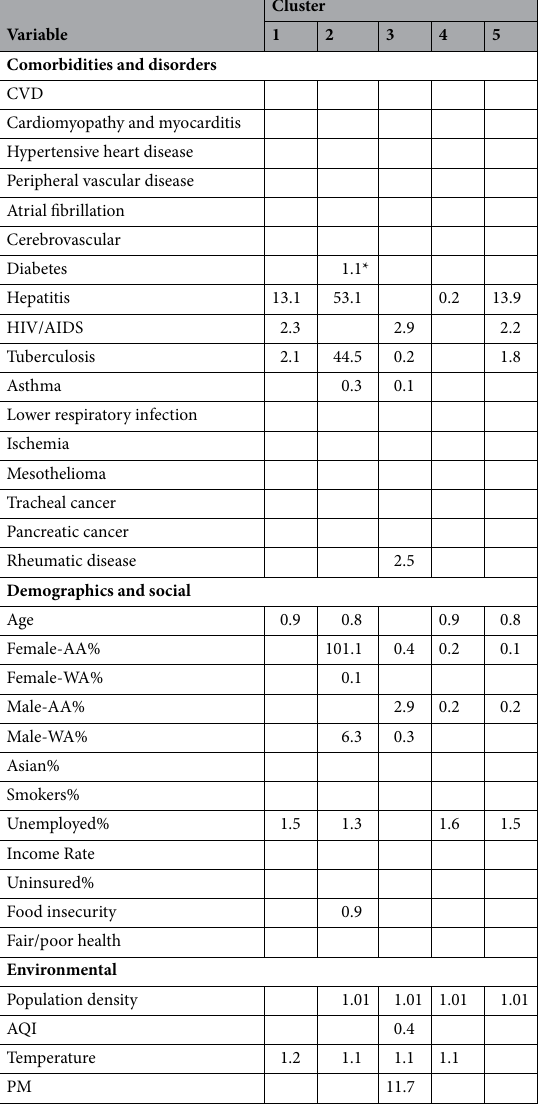
Table 6. 2nd Wave (Jun 4–Sep 2, 2020): significant risk factors and their odds ratios in each cluster compare to cluster 0 (counties with MIR = 0). Blank spots indicate the insignificant risk factors. *For instance, OR 1.1 means that 1% increase in diabetes MR is associated with a 10% increase in the relative log odds of being in cluster 2 vs. cluster 0 (MIR =